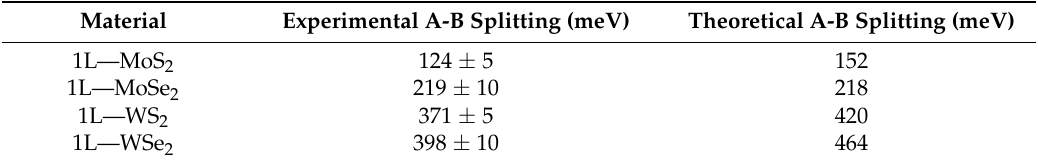
Table 1. Comparison of the spin-orbit splitting extracted from the differential reflectance spectra, and those obtained from ab initio calculations, including spin-orbit interaction.